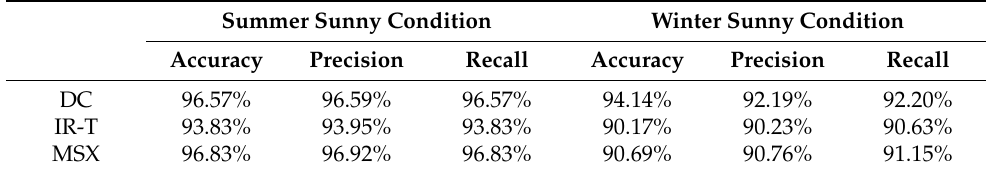
Table 5. Comparison of different input data in pavement crack detection.